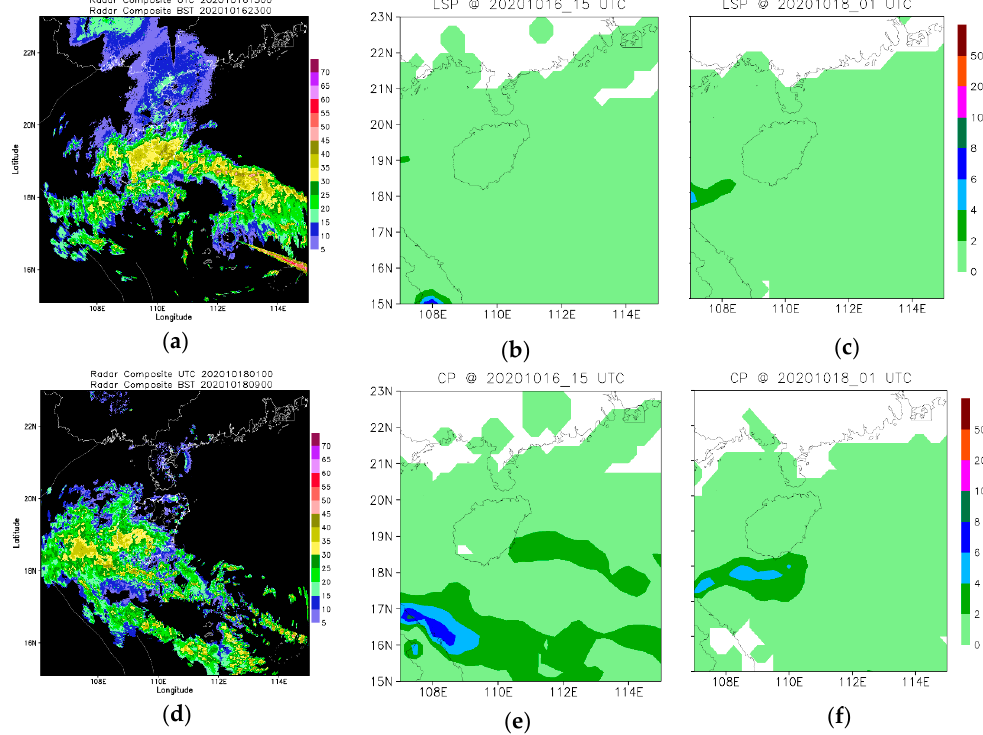
Figure 3. Composite radar reflectivity images ( a , d ; units: dBZ, shaded; blue and red arrows denote MCS1 and MCS 2 respectively) of 6 Doppler Radars (locations denoted in Figure 1d), hourly large- scale precipitation ( b , e , shaded, units: mm) and convective precipitation ( c , f , shaded, units: mm) at 1500 UTC 16 October and 0100 UTC 18 October 2020.